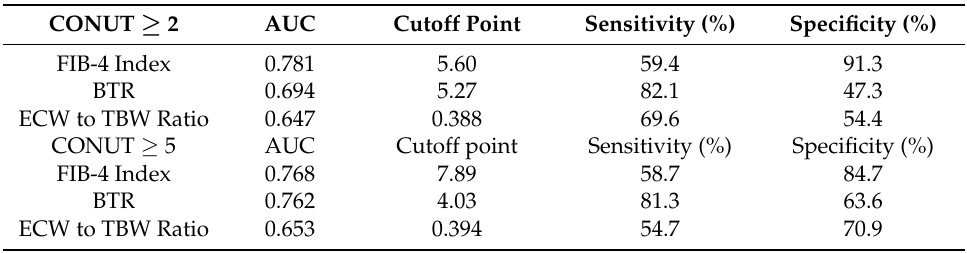
Table 8. ROC analysis for predicting CONUT score ≥ 2 and CONUT score ≥ 5.